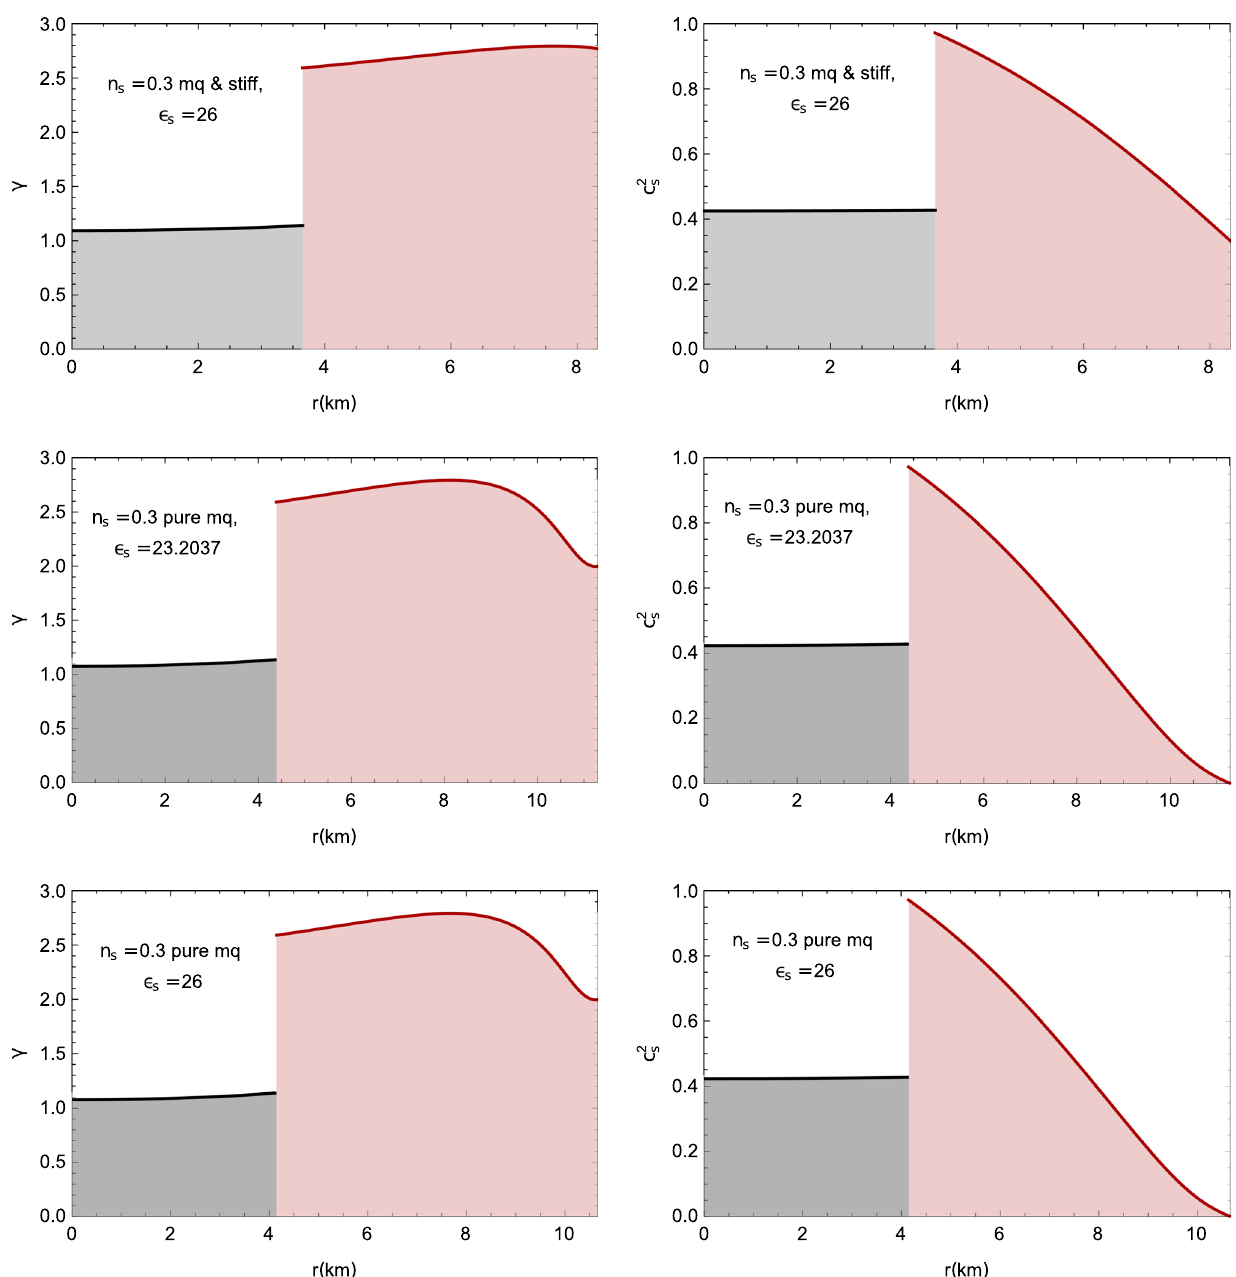
Fig. 8 The adiabatic index γ = d ln P and c 2 s of the multiquark core for each scenario, the multiquark core consists of two regions with high and d ln ρ low density given by (17) and